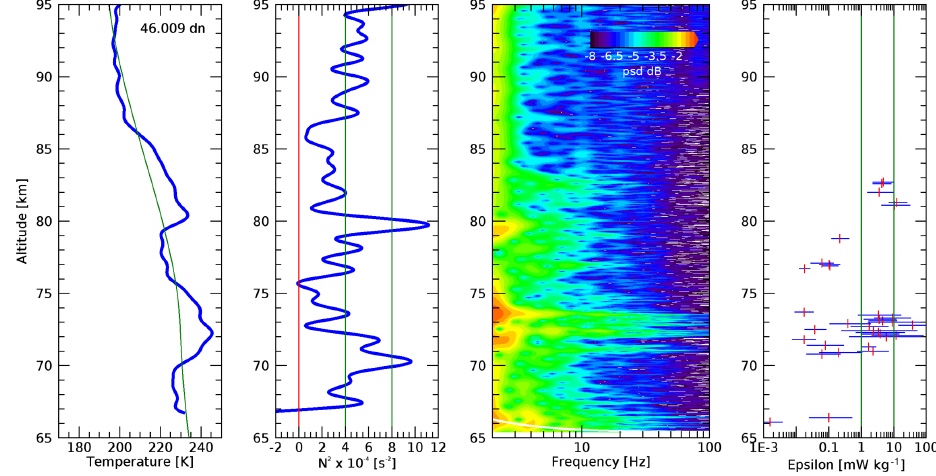
Figure 10. Same as Fig. 9 but for 46.009